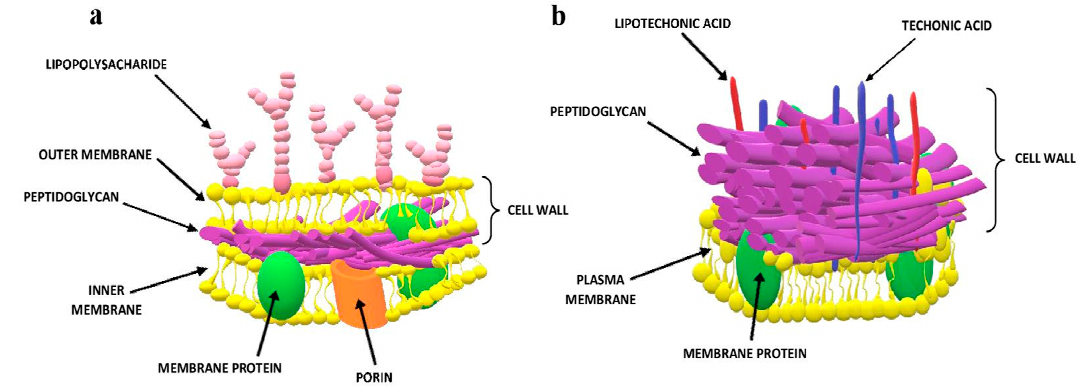
Figure 7. Di ff erences between Gram-negative ( a ) and Gram-positive ( b ) of bacteria cell Figure 7. Differences between Gram-negative ( a ) and Gram-positive ( b ) of bacteria cell wall.